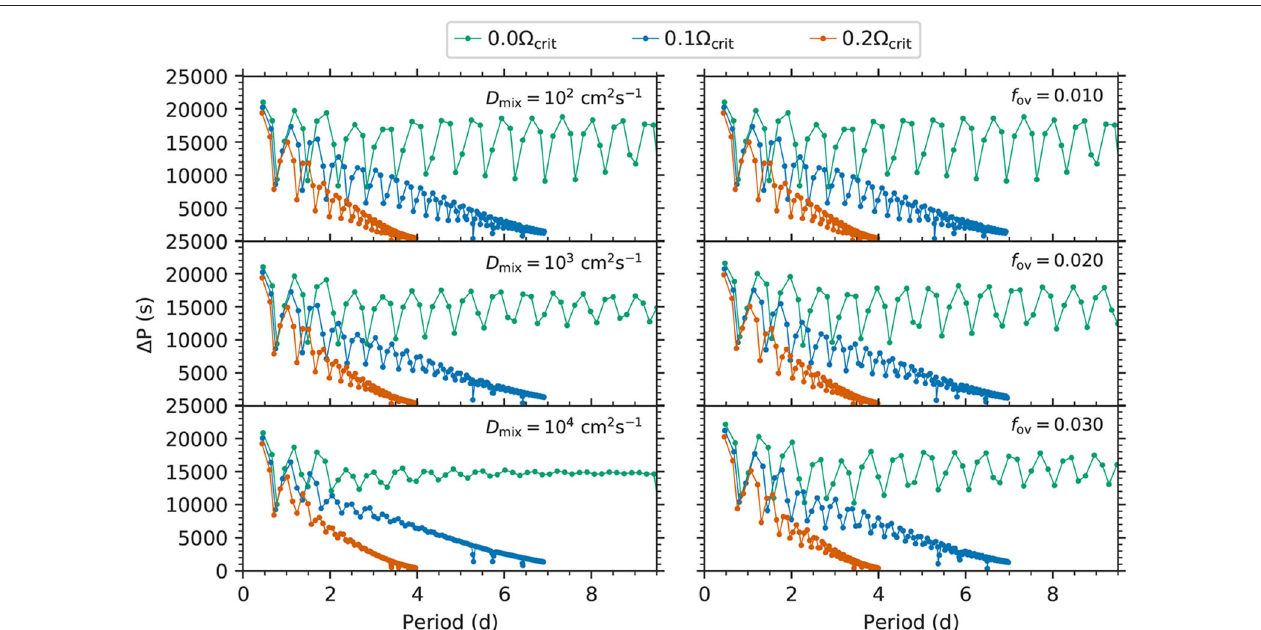
FIGURE 3 | Theoretical g-mode period spacing patterns for prograde dipole modes of a 12 M and right columns are for different envelope mixing ( D mix ) in cm 2 s − 1 , and exponential convective-boundary mixing ( f ov ) expressed in local pressure scale heights, respectively, calculated using the MESA stellar evolution code ( Paxton et al., 2019). For each panel, three different rotation rates expressed as a fraction of the critical rotation rate, (cid:127) crit , calculated using the Traditional Approximation for Rotation (TAR) using the GYRE pulsation code ( Townsend and Teitler, 2013) are